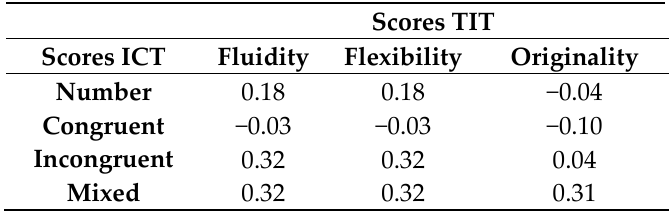
Table 6. Pearson correlation scores between instruments (N =